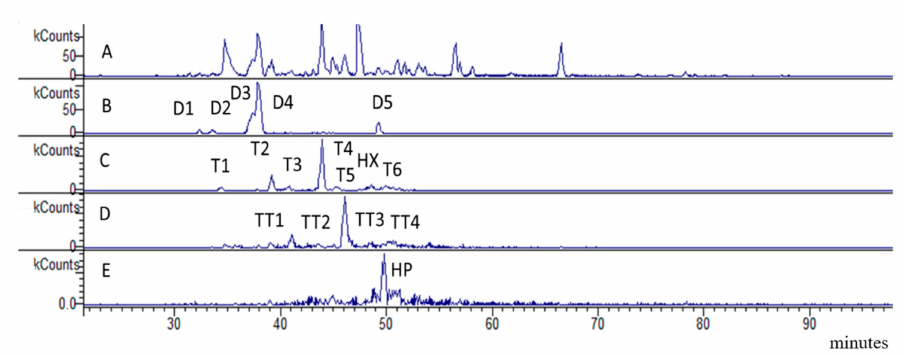
Figure 5. B. retusa bark, LC-MS chromatogram peaks, identified compounds are indicated as in Table 2. ( A ). total ion current of chromatogram; ( B ), proacyanidin dimers:D1–D5; ( C ), procyanidin trimers and